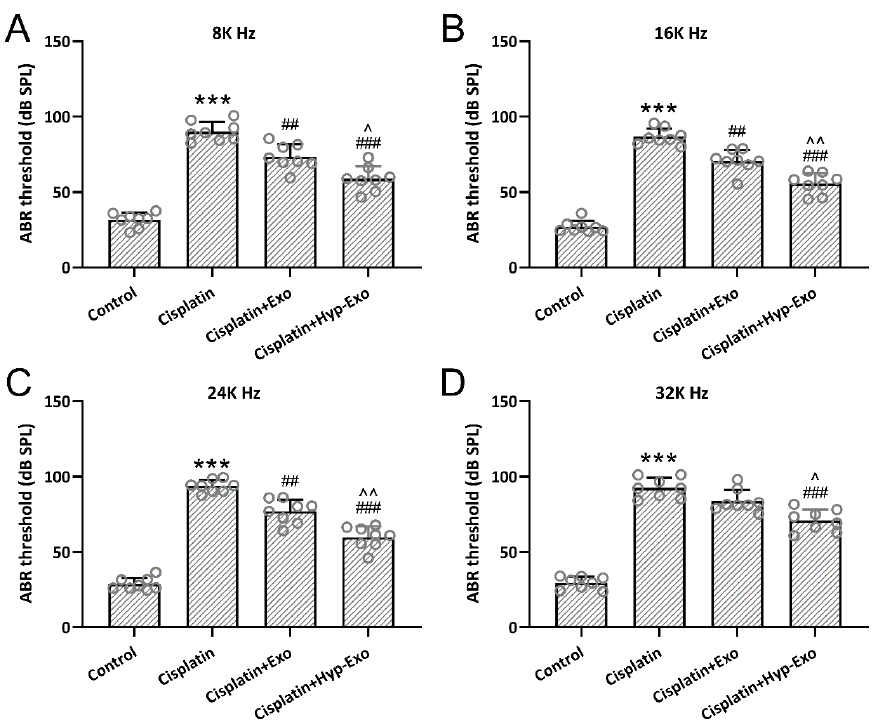
Figure 4. HypBMSC-Exo ameliorated cisplatin-induced hearing loss in vivo. ( A – D ) ABR measure- ments revealed that hypBMSC-Exo reduced hearing thresholds at 8, 16, 24, and 32 kHz, respectively, in cisplatin-exposed mice. The data are shown with mean ± SD. n = 8 for each group. *** p < 0.001 compared to control, ## p < 0.01, ### p < 0.001 compared to Cisplatin, ^ p < 0.05, ^^ p < 0.01 compared to Cisplatin + Exo. One-way ANOVA followed by Tukey’s multiple comparisons test. ABR,